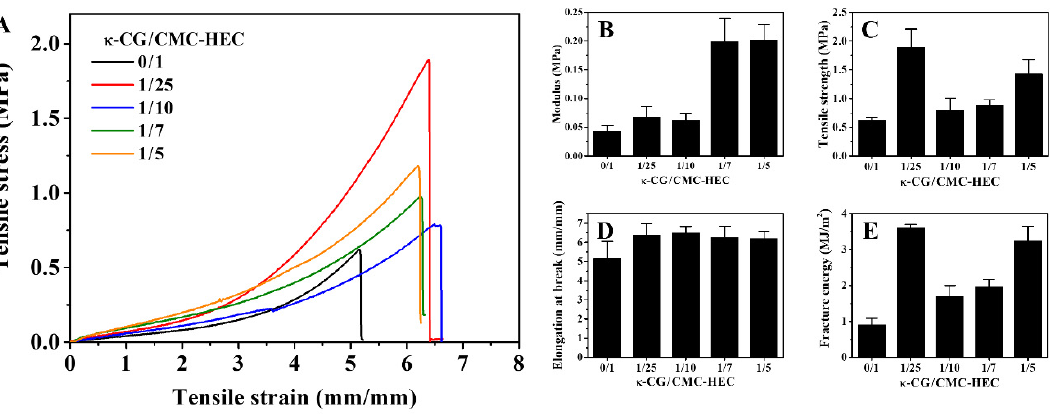
Figure 3. ( A ) Tensile stress–strain curves and ( B – E ) the corresponding mechanical parameters of the κ -CG/CMC–HEC hydrogels with different κ‐ CG/CMC–HEC hydrogels with different compositions.